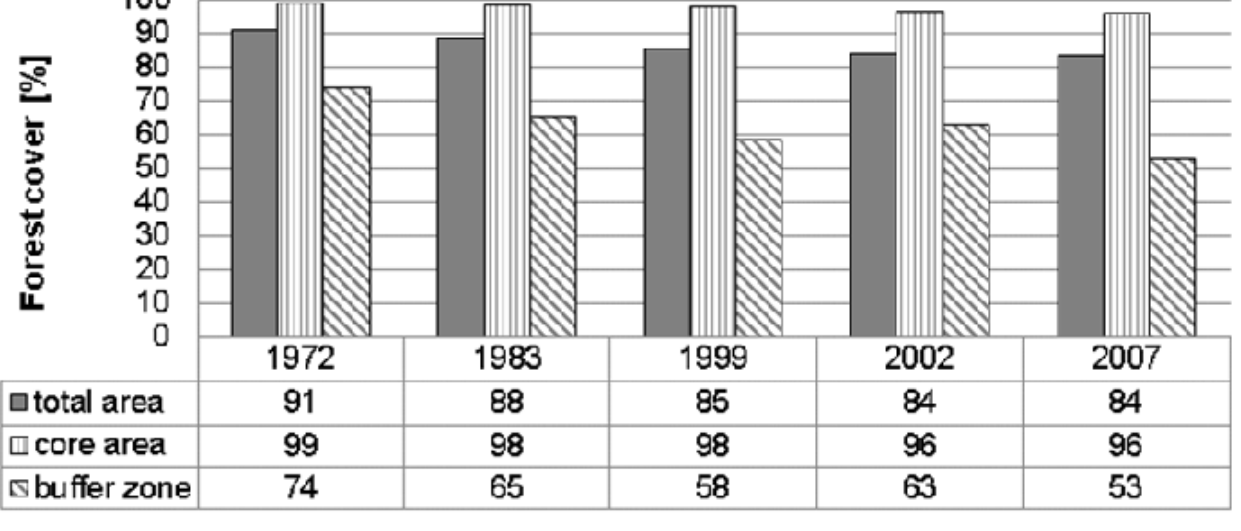
partner is shown. Fig. 4 . Deforestation rate (%/year) in Lore Lindu Biosphere Reserve before and after establishing management